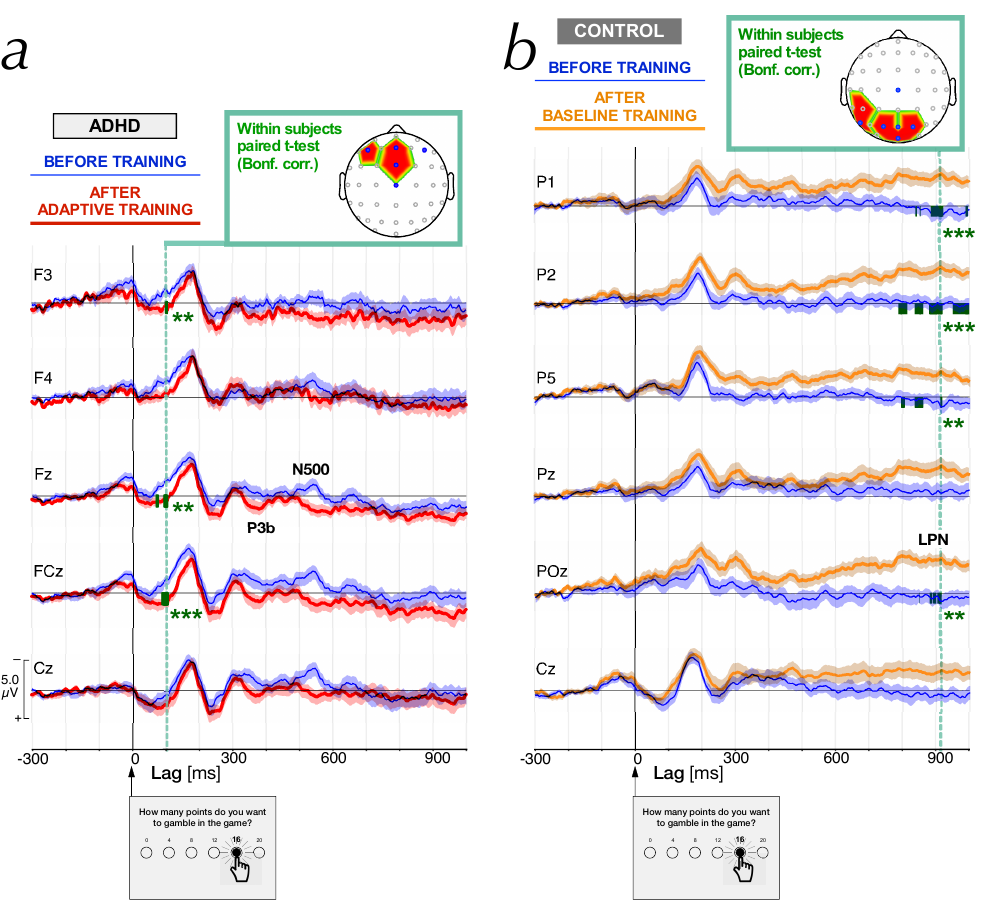
Figure 5. Grand average ERPs, triggered (at lag 0 ms) by the button-click at the time of the selection of the amount to gamble, recorded before working memory training (blue curves and shaded areas). The confidence interval (mean curve ± SEM) is shown by the shaded areas. The vertical scale represents the amplitude of the signal in µ V and the lag is scaled in milliseconds. ( a ). Grand average ERPs at sites F3, F4, Fz, FCz and Cz sites (blue marks in the head map) for ADHD participants recorded after training with the adaptive level protocol (red curves and shaded areas) for the dual n -back task. Green ticks show the significant Bonferroni-corrected 1 − p values computed from paired t -test on individual average ERP signal with significance p < 0.05 (**) and p < 0.01 (***). The panel at the top, shows a head map with the significant sites after Bonferroni correction (red areas around F3, Fz and FCz), at a latency of 100 ms (dashed green vertical line), corresponding to the P1-like component discussed in the text. ( b ). Grand average ERPs at sites P1, P2, P5, Pz, POz, and Cz sites (blue marks in the head map) for controls recorded after training with the baseline level protocol (orange curves and shaded areas), i.e., after the dual 1-back task. In this figure, the head map on the top shows the significant sites (in red areas around P1, P2, P5, CP3 and POz) at a latency of 912 ms (dashed green vertical line), corresponding to the slow negative wave component associated with the expectation of the gambling